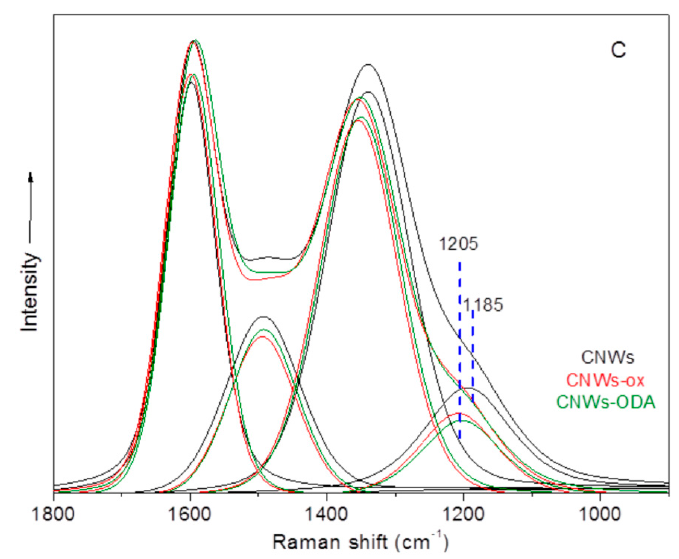
Figure 3. ( a ) Raman spectra of CNWs, CNWs-ox and CNWs-ODA samples; ( b ) normalized spectra; and ( c ) spectra analyzed to Gaussian profiles.